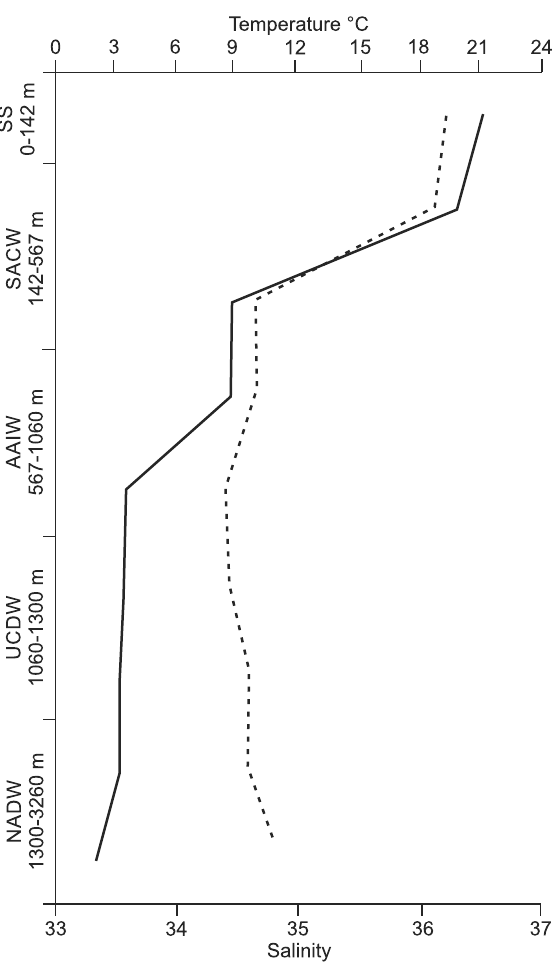
Figure 2. Salinity and temperature of the five water masses (0- 3260 m) in the Campos Basin, central Brazilian coast, according to data from M ÉMERY et al. (2000) and S ILVEIRA et al . (2000). Solid line = temperature, dashed line = salinity. SS – Subsurface Water, SACW – South Atlantic Central Water, AAIW – Antarctic Interme- diate Water, UCDW – Upper Circumpolar Deep Water, NADW – North Atlantic Deep